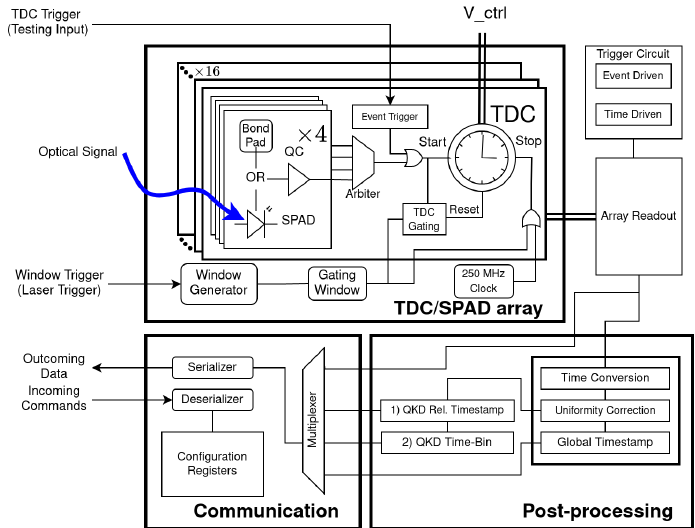
Figure 2. Block diagram of the all subsystems of the PDC, illustrating the signal flow. Each SPAD of the 8 × 8 array has its own quenching circuit, and 2 × 2 sub-arrays of SPADs are assigned to a TDC (16 in total). The array of TDCs is read out and the data pass through post-processing to the output serializer. The blue arrow indicates an incoming photon on the